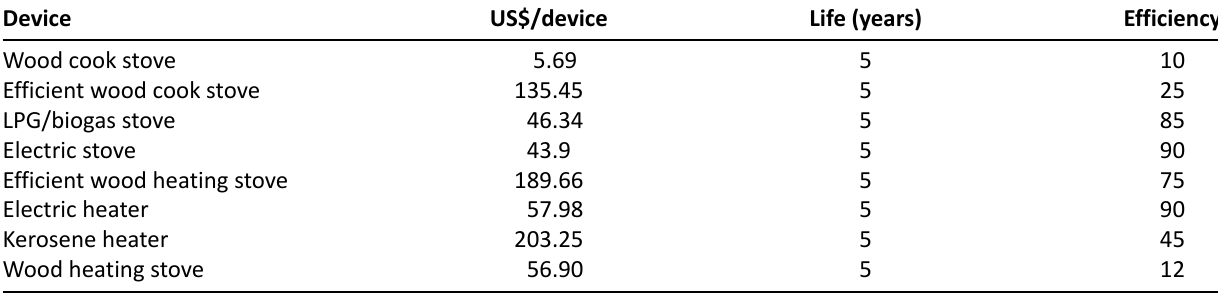
Table A5. Cooking and heating end-use technology in the residential and service sectors UNDP (2012); Yangka & Diesendorf (2016).